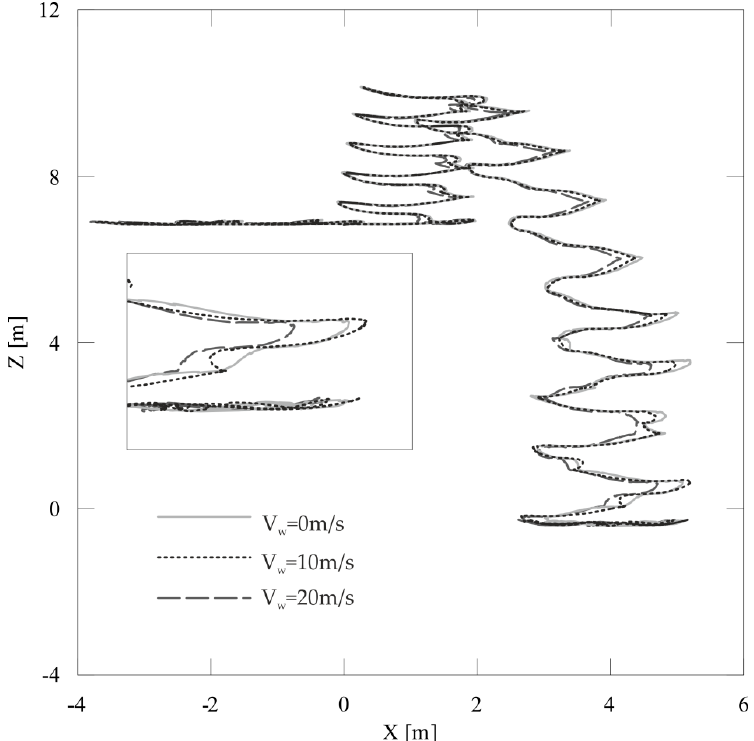
Figure 20. Trajectory projections of the carried load’s center of mass in one of the lifting planes (wind power having impact according to the direction of the X axis).